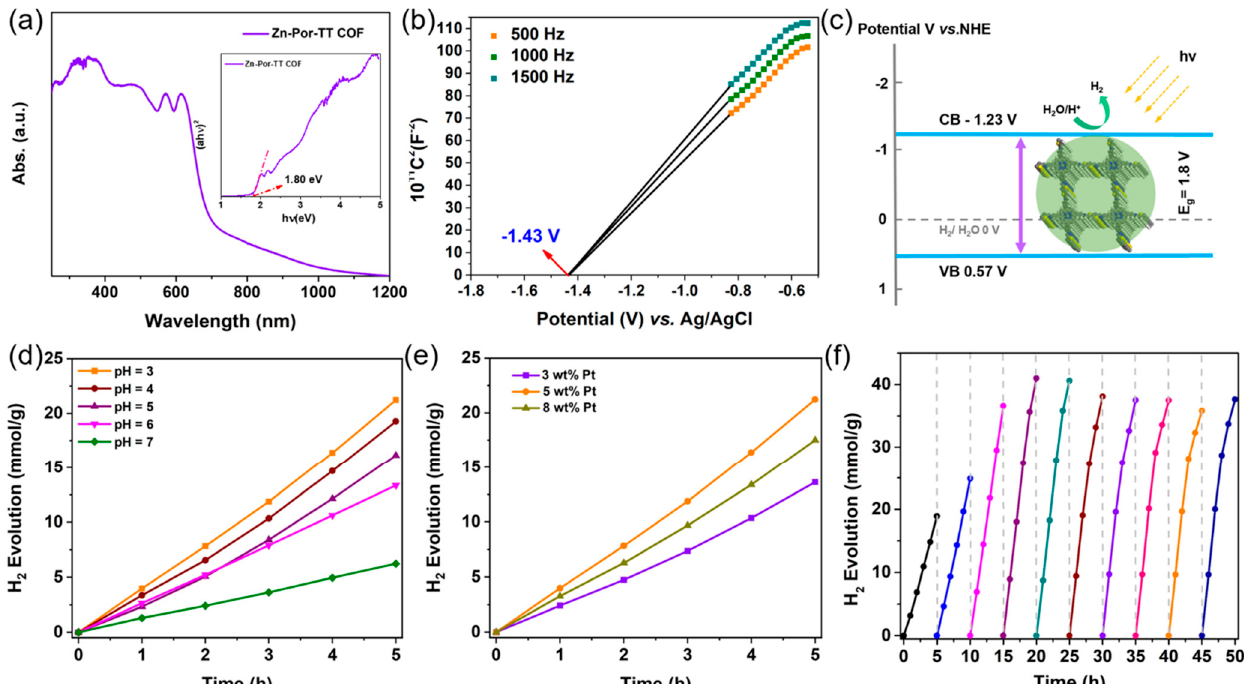
Figure 6. ( a ) UV-Vis DRS spectrum of Zn-Por-TT COF, insert: (ah υ ) 2 versus h υ curve of Zn-Por-TT COF; ( b ) Mott–Schottky (M-S) plots of Zn-Por-TT COF at 500 Hz, 1000 Hz, 1500 Hz; ( c ) the CB and VB positions of Zn-Por-TT COF; ( d ) H 2 evolution rate of Zn-Por-TT COF under different acidity; ( e ) H 2 evolution rate of Zn-Por-TT COF with different Pt loading amounts; ( f ) time course of H 2 productions under visible light ( λ > 400 nm) irradiation of Zn-Por-TT COF.